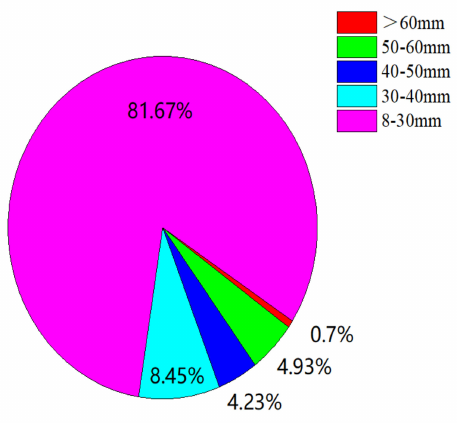
Figure 1. Casing inner diameter change of 144 casing deformations at Weiyuan block.